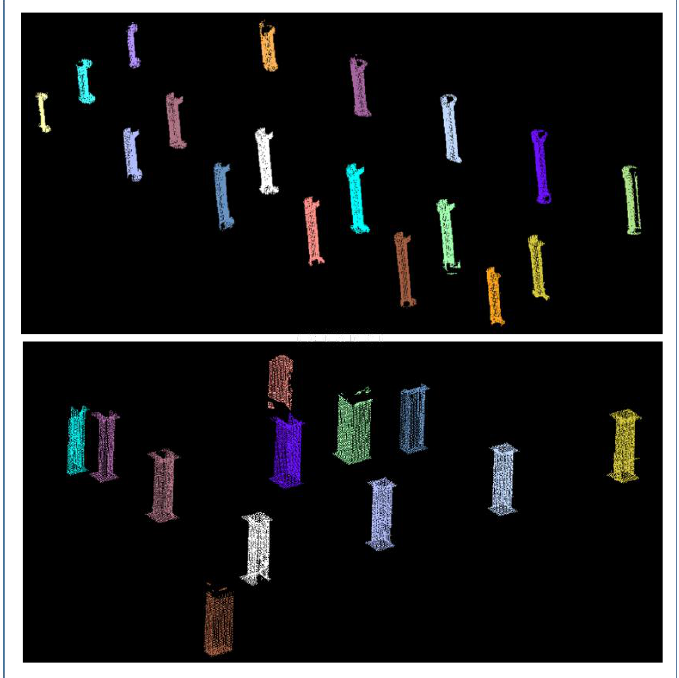
Figure 13. Image with segmented columns visualized with different colors (case study 1.a and case study